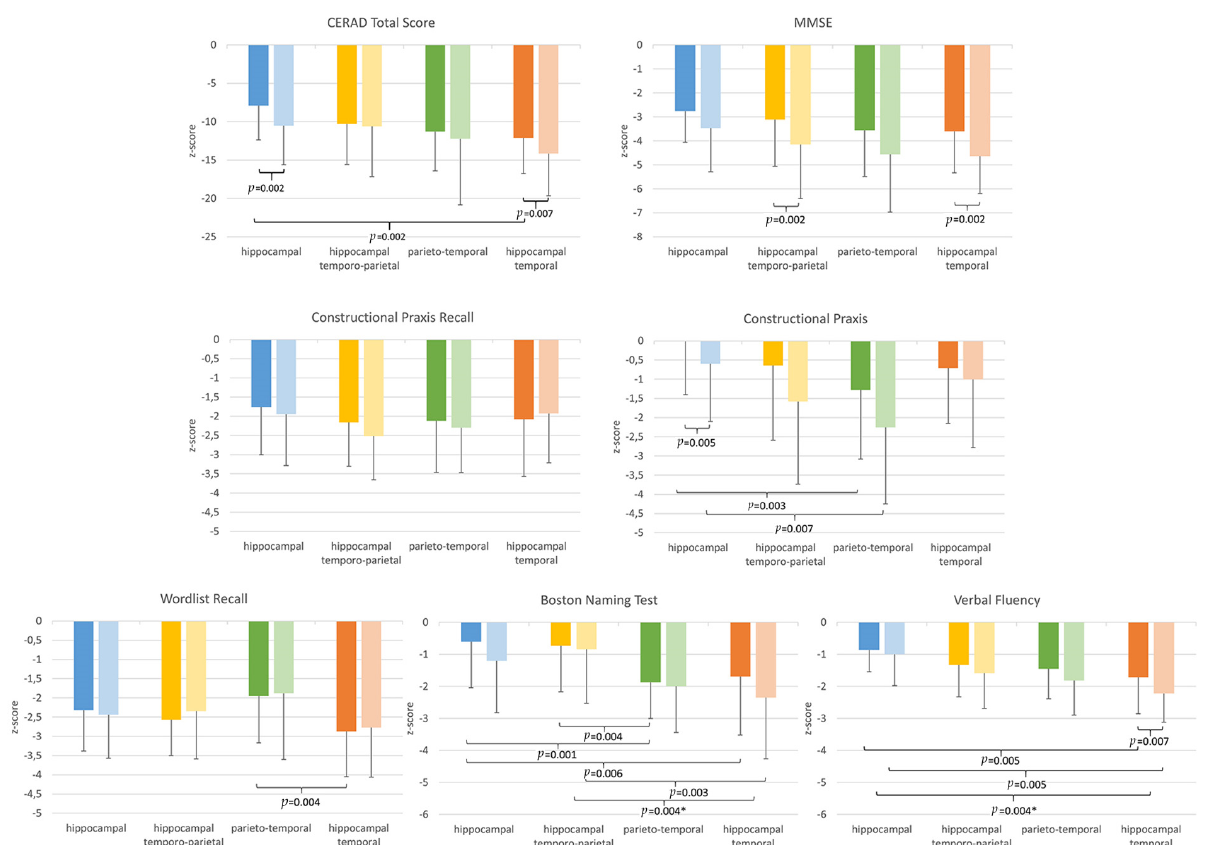
Figure 3. Neuropsychological test results. Bar plots of cognitive test scores of morphometrically defined Alzheimer’s disease subtypes at baseline (dark color) and one-year follow-up (light color). p values derived from group comparisons between AD subtypes. * Significant longitudinal differences of respective groups from baseline to follow-up time point.